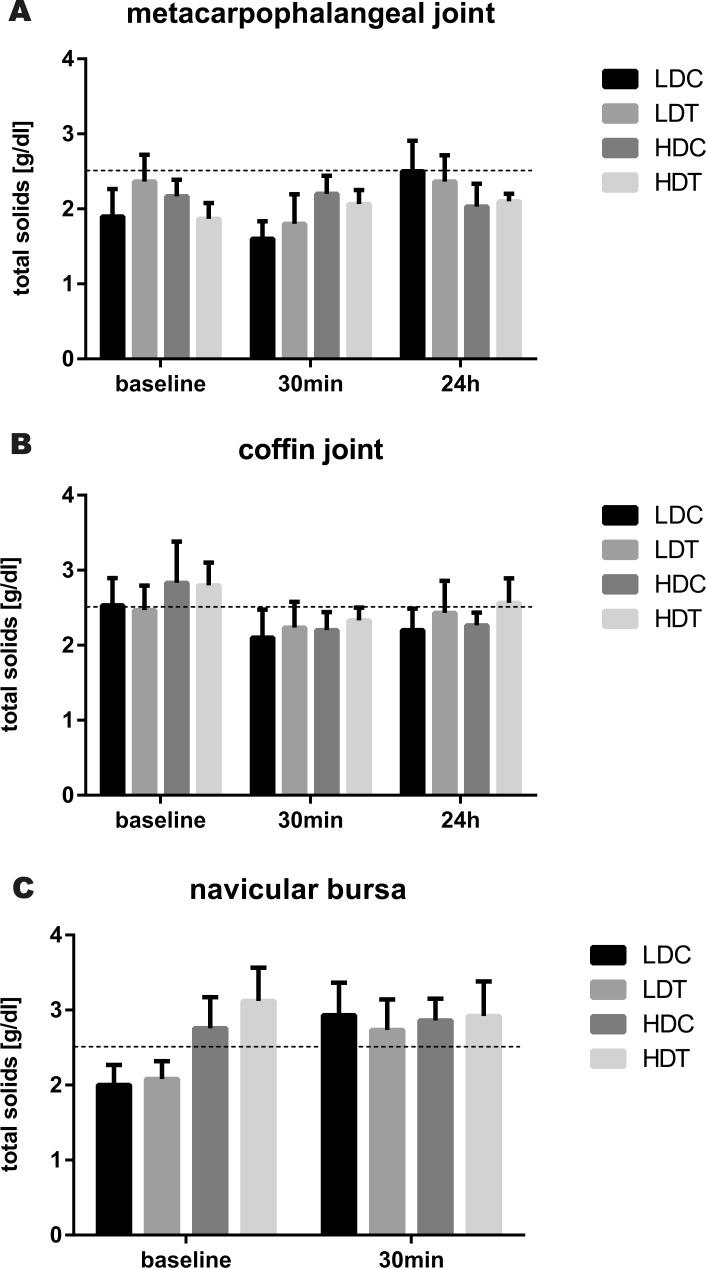
Bar graphs illustrating synovial fluid total solids concentrations after IVRLP with tiludronate or saline.Synovial fluid total solids concentrations over time after IVRLP with 0.5 mg (LDT) or 50 mg (HDT) tiludronate diluted in 50 ml saline in one randomly assigned forelimb or with 50 ml saline in the contralateral forelimb as control for the low dose (LDC) or as control for the high dose of tiludronate (HDC). Synovial fluid was sampled from the metacarpophalangeal joint (A), the coffin joint (B) and the navicular bursa (C). The dotted line represents the upper limit of the normal reference interval (Davidson & Orsini, 2007). Error bars represent SEM.